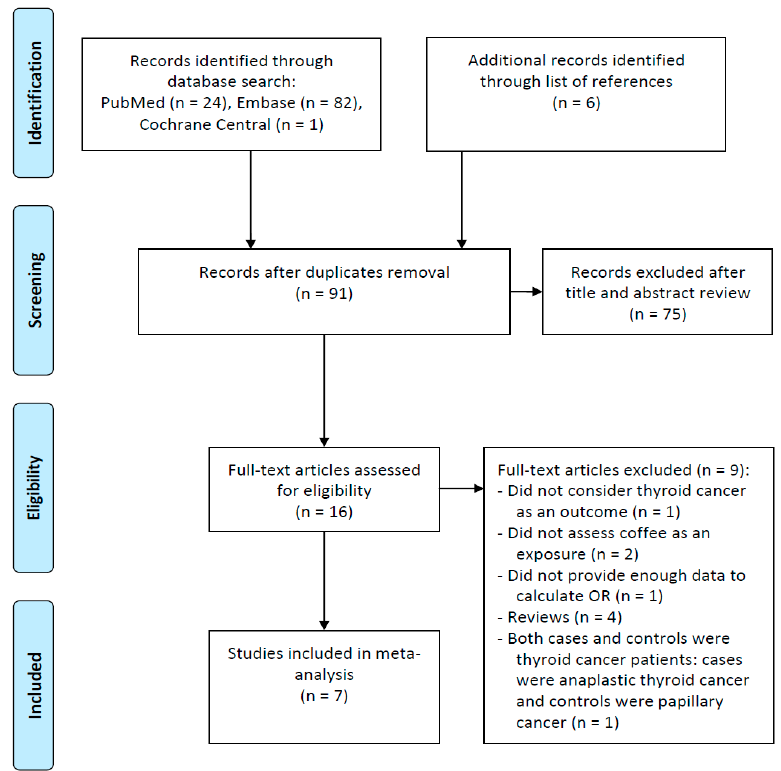
Figure 1. Flowchart of study selection process.